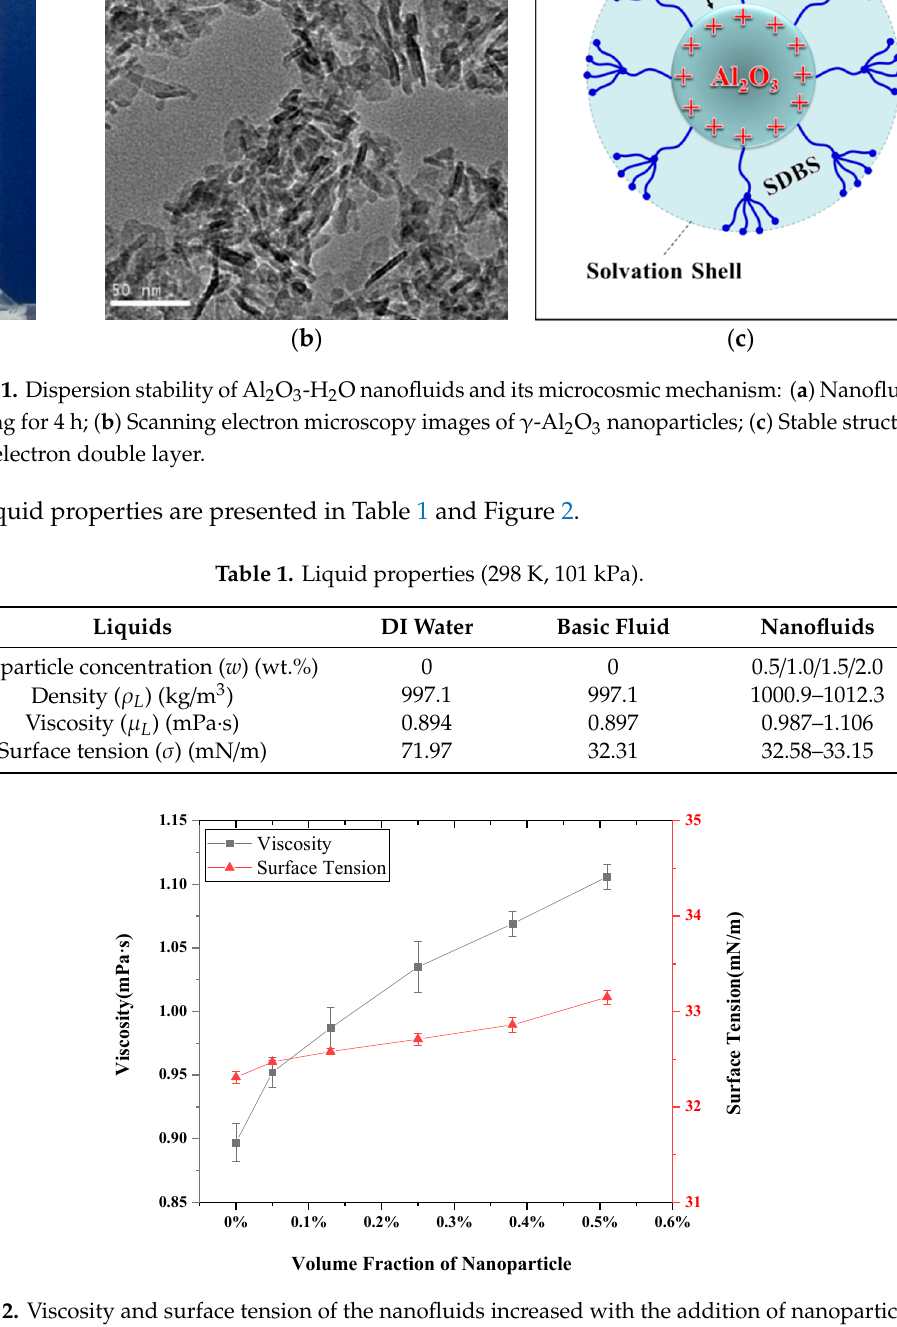
Figure 2. Viscosity and surface tension of the nanofluids increased with the addition of nanoparticles.